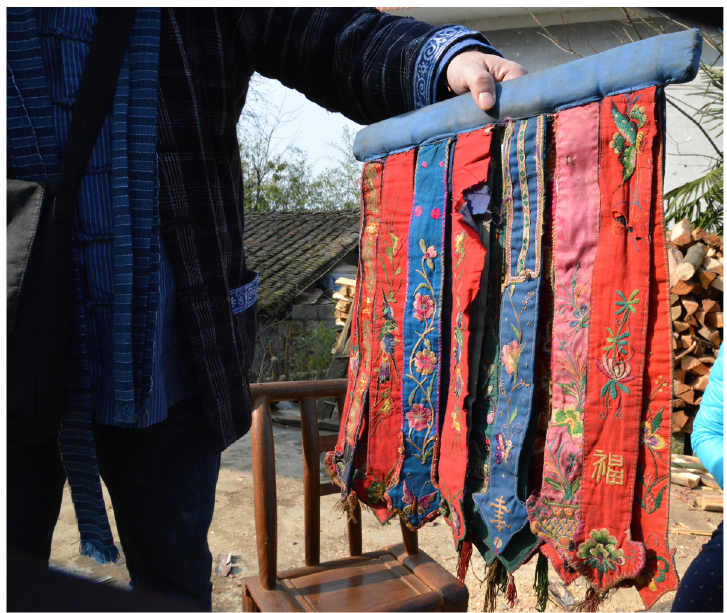
Figure 3. A liu jin used by badai to sweep away evil spirits. Each cloth was embroidered by families from the village and given to the badai to protect the village. (Photo: Thomas Riccio). A xianniang, when in a state of trance, is often asked by the badai to identify and locate the evil spirits affecting the family. The xianniang, channeling the family ancestors, and kill the demons.